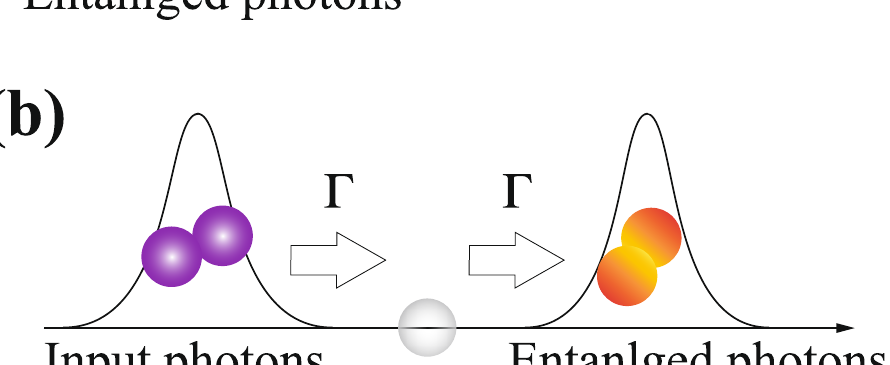
. ψ | ⟩ indicates the quantum in